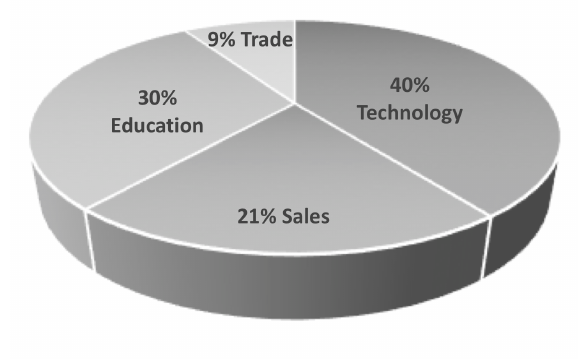
Fig. 1. Distribution of Subjects by Profession